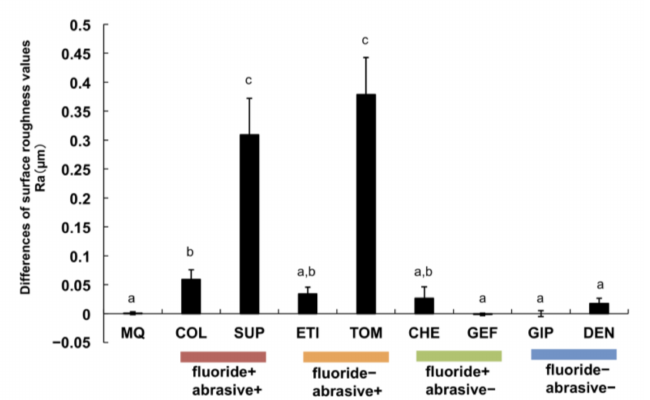
Figure 2. Influence of brushing with toothpastes or MQ on titanium surface roughness. Surface roughness values represent the variations with the values of the control sample. Independent experiments were repeated three times. Data represent the means ± SD of triplicate experiments. The different letters among the samples indicate a statistically significant difference ( p < 0.05 or p < 0.01).